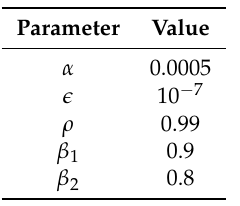
Table 2. Optimization algorithms’ adjusted